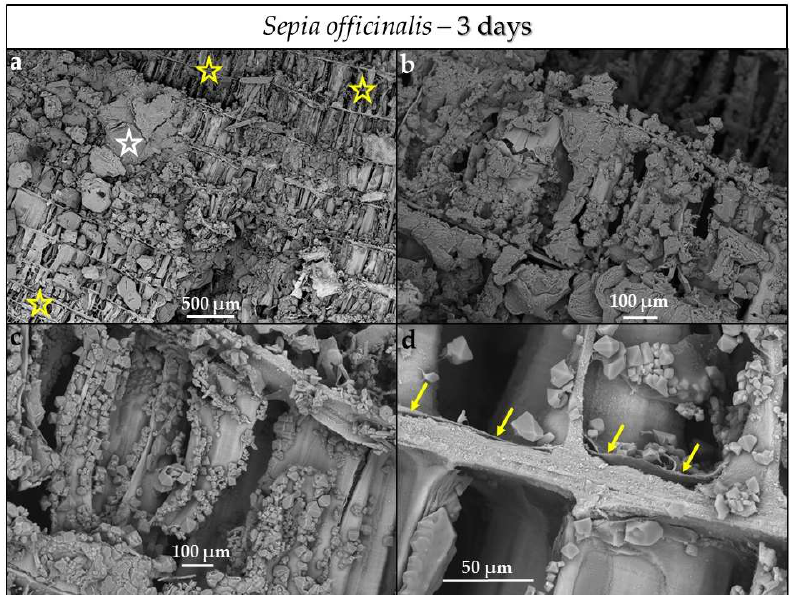
Figure 10. ( a – d ) FE-SEM images showing the Sepia officinalis cuttlebone ultrastucture when altered for 3 days. The original ultrastructure (yellow stars in ( a )) is highly ruptured up to complete distortion (white star in ( a )). Biopolymer membranes lining the chambers are not entirely decomposed yet (yellow arrows in ( d )): However, they become detached from the surface of the skeletal element.